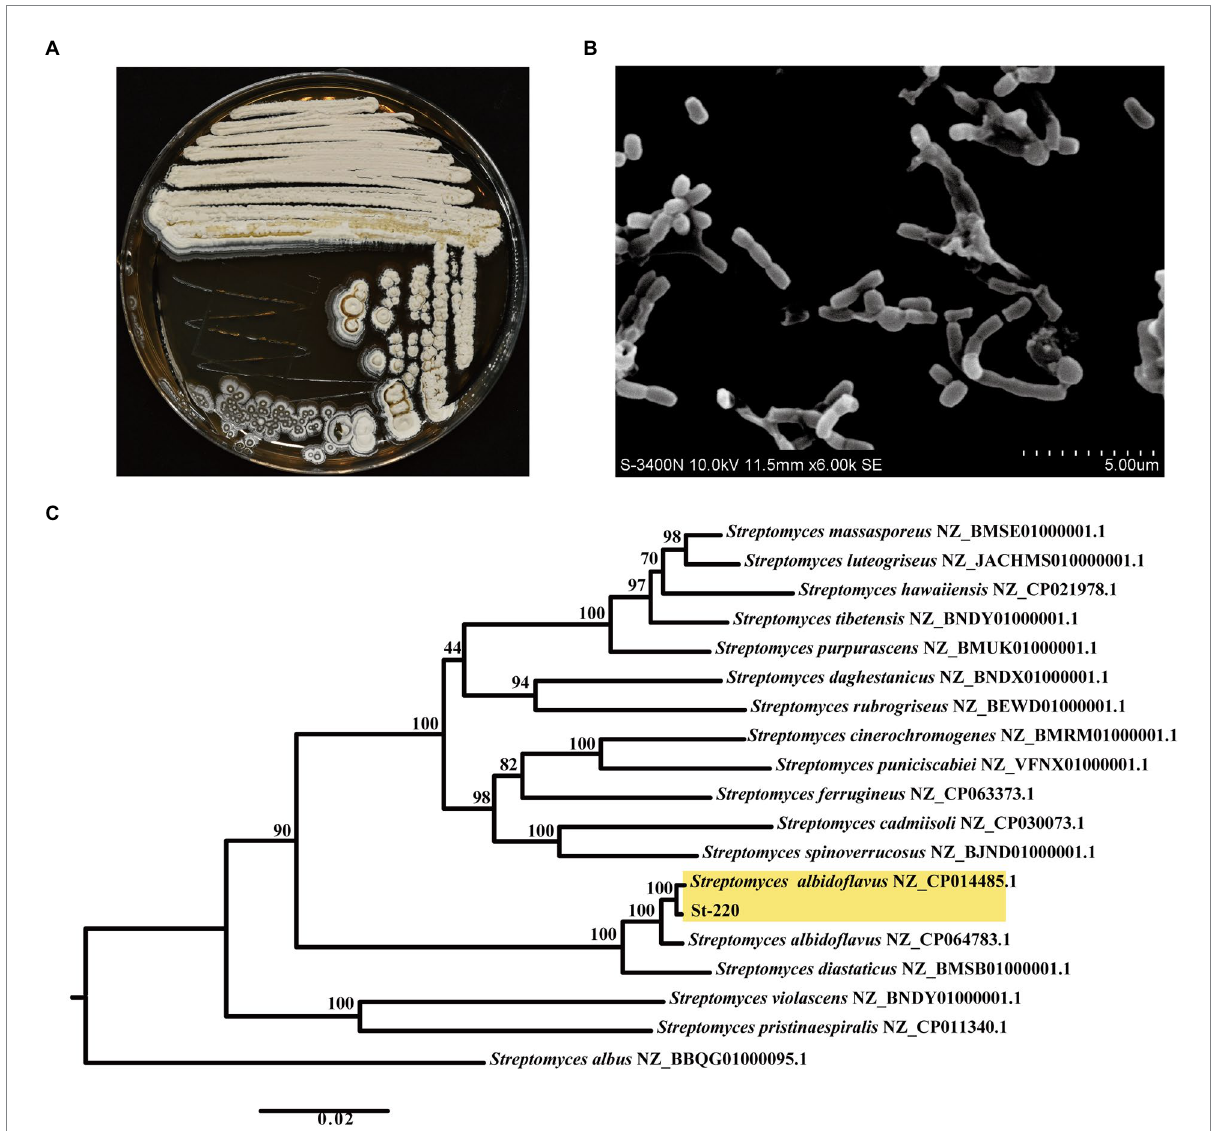
FIGURE 5 Morphological and molecular identification of strain St-220. (A) Colony morphology of the strain St-220 on PDA medium after 14 days of incubation at 28 ° C. (B) Spores of St-220 observed under scanning electron microscope after incubated on PDA medium for 14 days at 28 ° C. (C) A phylogenetic tree using the maximum likelihood method based on the sequences of 16S rDNA and 5 housekeeping genes with 1,000